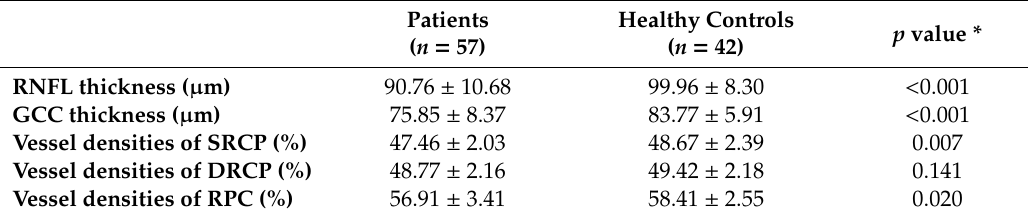
Table 2. Comparison of intraretinal layer thickness and parafoveal and peripapillary vessel densities between patients with chiasmal compression and healthy